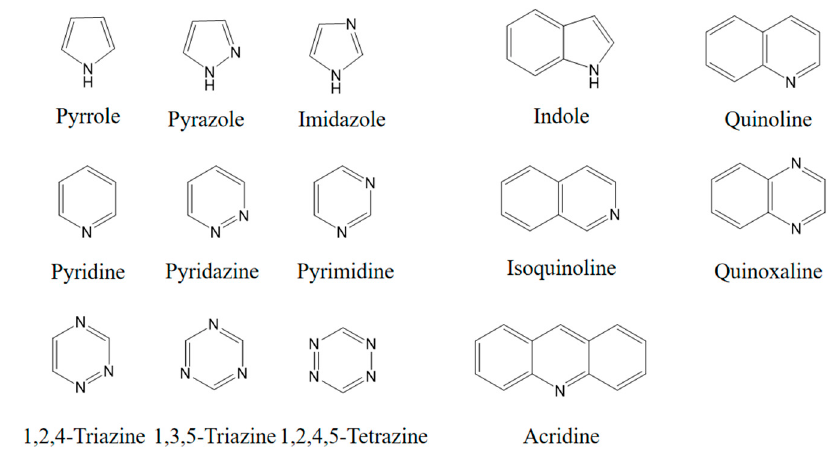
Figure 1. Illustration of the molecular structure of commonly used